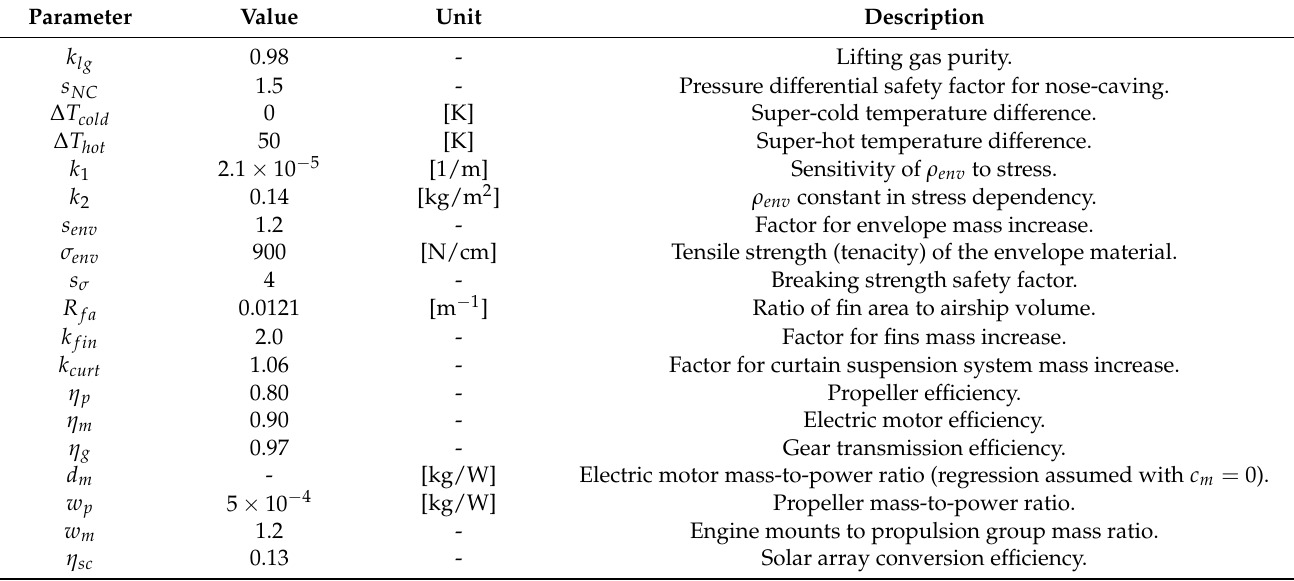
Table 1. Fixed parameters for a sizing loop and assumed values for computations in Section